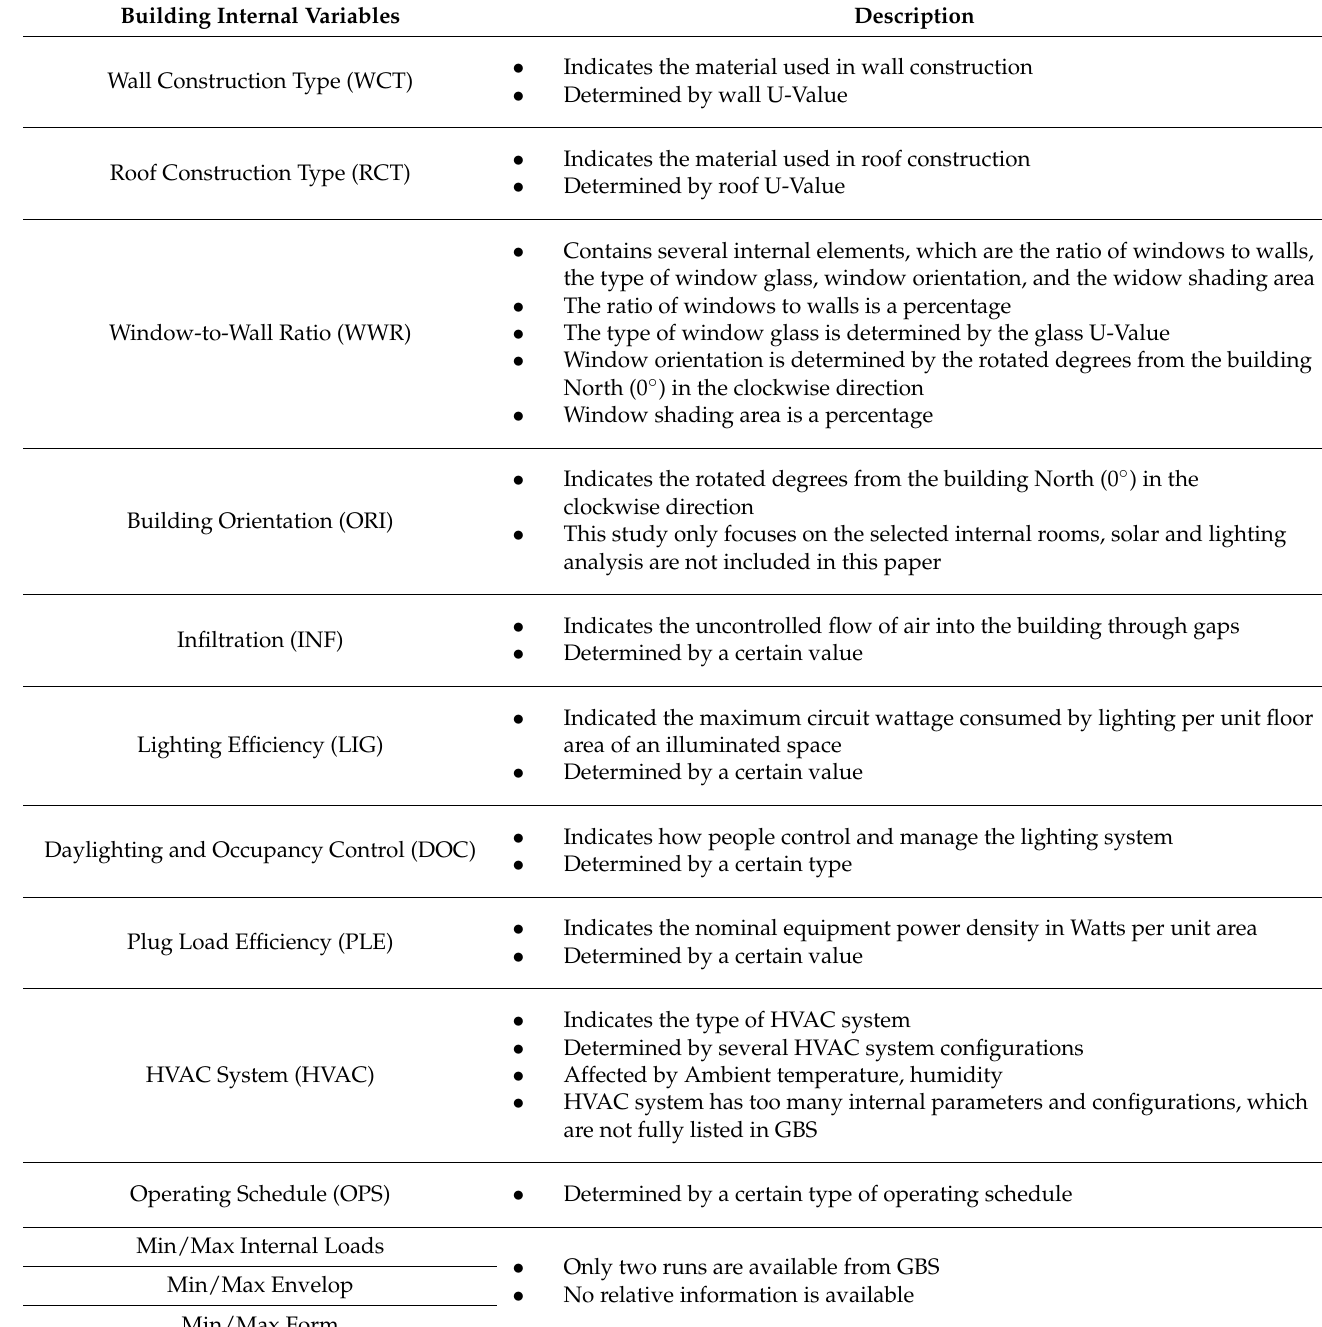
Table 6. Selected building variables from